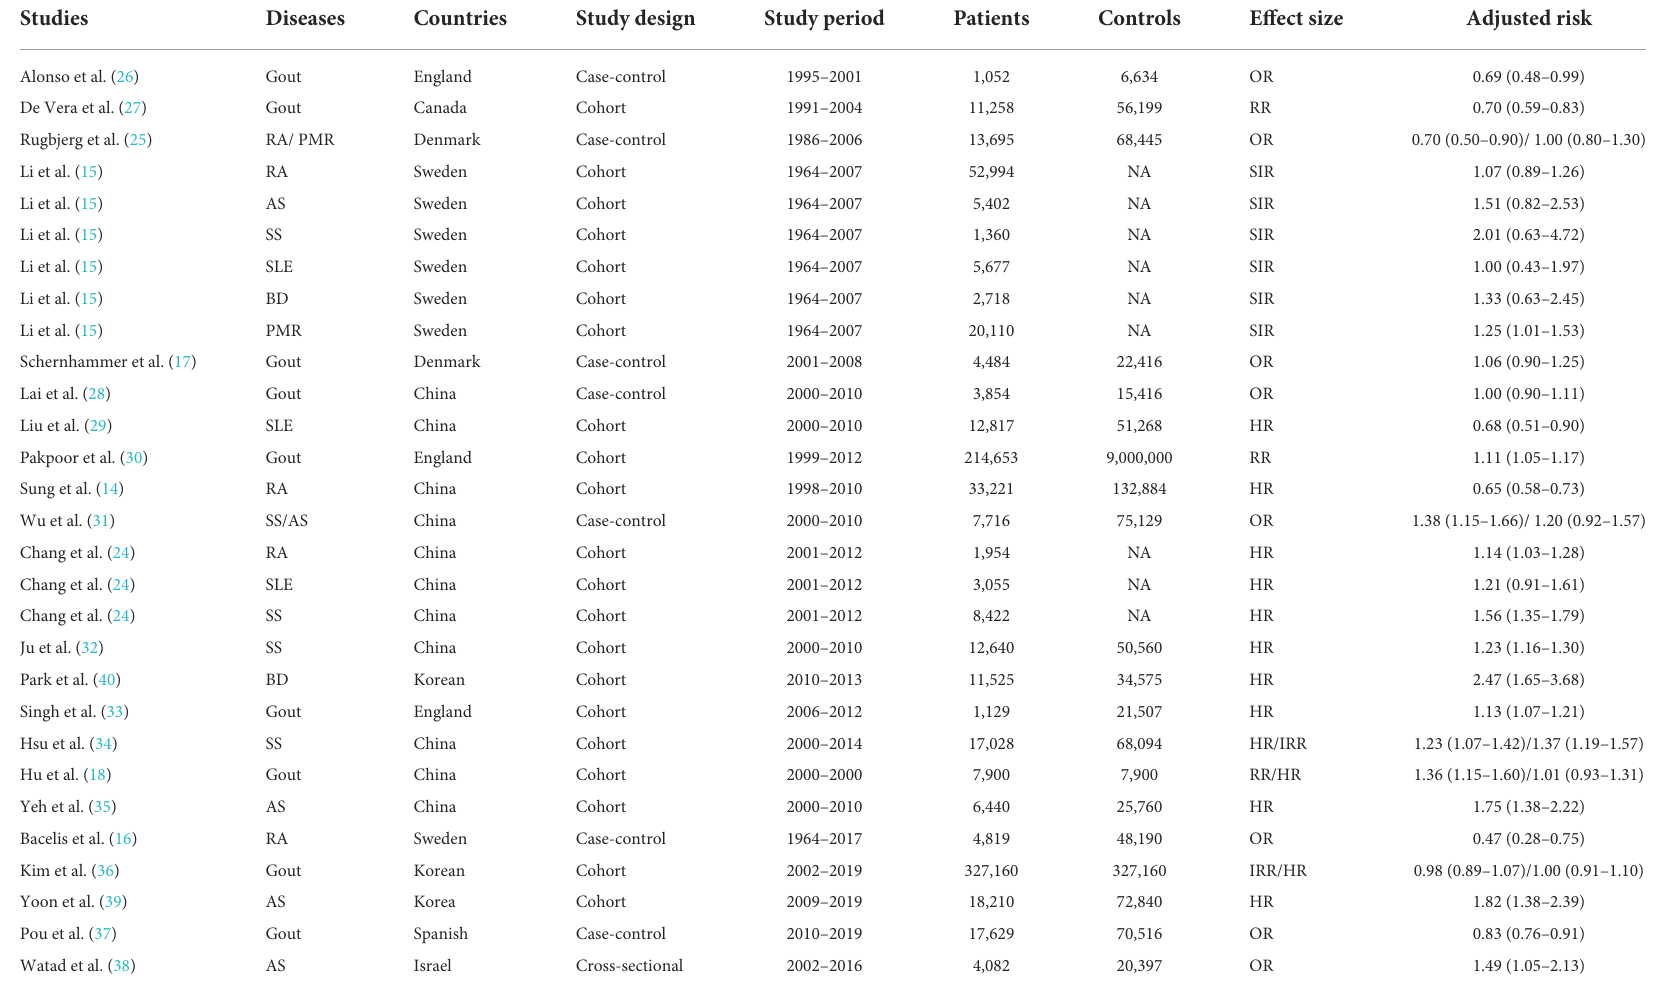
TABLE 1 Characteristics of included